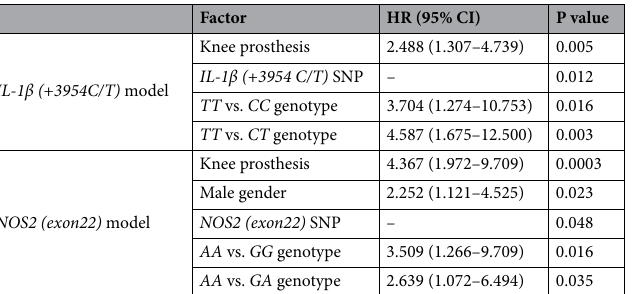
Table 5. Factors independently associated with prosthesis loosening according to the multivariate Cox